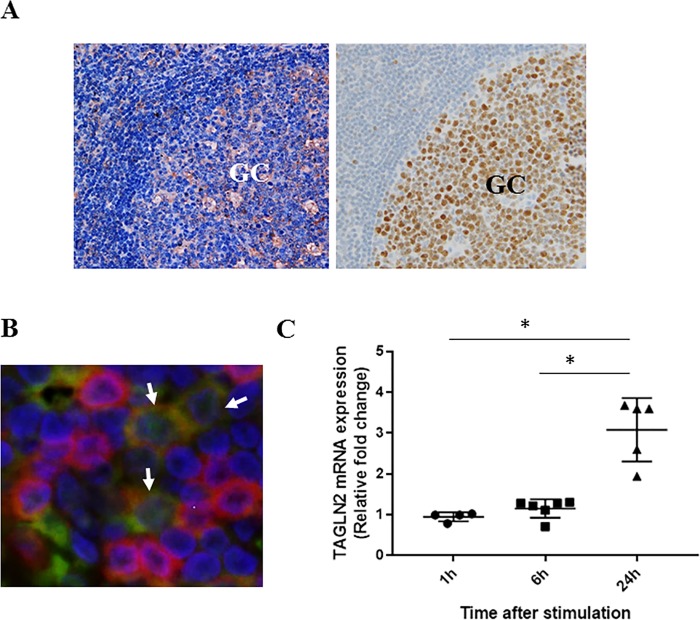
TAGLN2 mRNA is induced upon BCR stimulation and significantly expressed on activated B-cells in the germinal center.(A) Immunohistochemistry showing TAGLN2 localized in the germinal center in human secondary lymphoid tissues (left) and Bcl-6 expression, a marker of germinal center B-cells (right) (original magnification, x400). GC, germinal center. The figure is representative of 5 tonsils examined. (B) Double immunofluorescence analysis of TAGLN2 (green) and the B-cell marker CD20 (red), showing coexpression of TAGLN2 and CD20 in the germinal center. Nuclei were stained with DAPI (arrows, original magnification, x400). (C) TAGLN2 mRNA is induced upon BCR stimulation. TAGLN2 mRNA levels were measured in primary human B-cells from six different healthy donors at the indicated time points after IgM+IgG stimulation using qRT-PCR. At each time point, the TAGLN2 mRNA levels in anti-IgM+IgG stimulated cells (stim) are expressed fold change relative to the levels in non-stimulated (non-stim) cells. The mean TAGLN2 mRNA expression ratio was 0.93-fold at 1 h, 1.09-fold at 6 h, and 2.85-fold at 24 h after stimulation, suggesting that TAGLN2 mRNA was induced by 24-h B-cell activation (p<0.05, paired t-test vs. non-stimulated control). Data are presented as the mean ± SEM. *p<0.05.